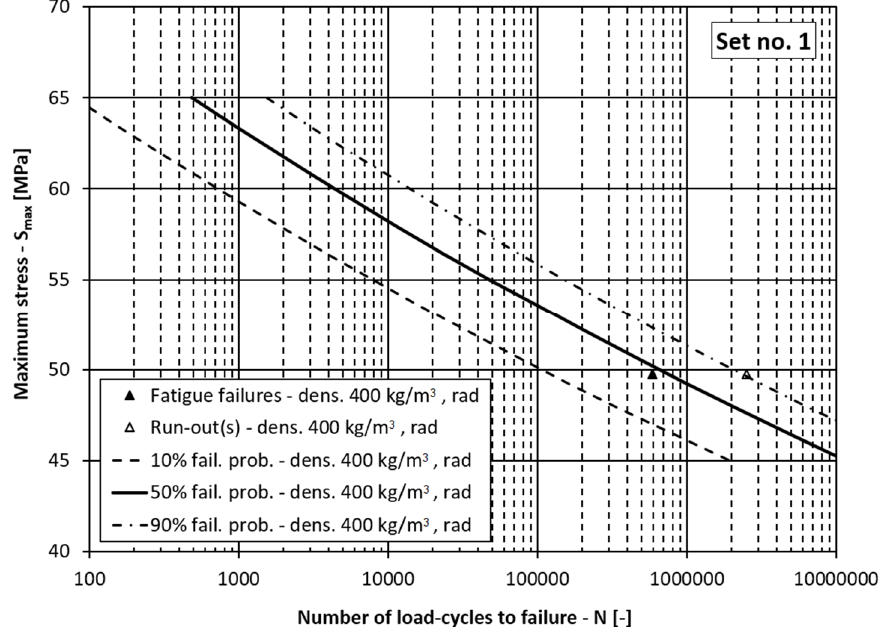
Figure 6. Fatigue-life curves for processing lot 1 and the radial loading direction. (fail. prob. = failure probability, dens. = wood mass density).